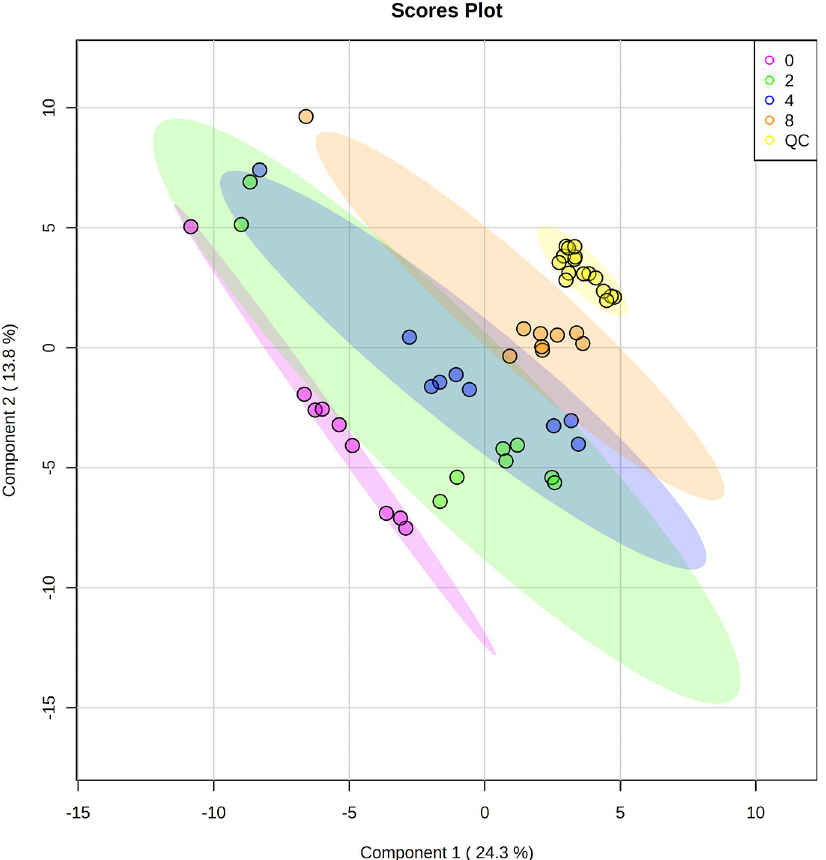
Fig 1. Multivariate analysis of metabolite profiles from mouse serum after T . spiralis infection, using partial least squares-discriminant analysis (PLS-DA). Violet, green, blue, and orange dots represent data from before infection, and 2-, 4-, and 8-weeks PI, respectively. QC samples were presented in yellow dots. PLS-DA showed good discrimination of metabolite profiles between different timepoints of T . spiralis infection.